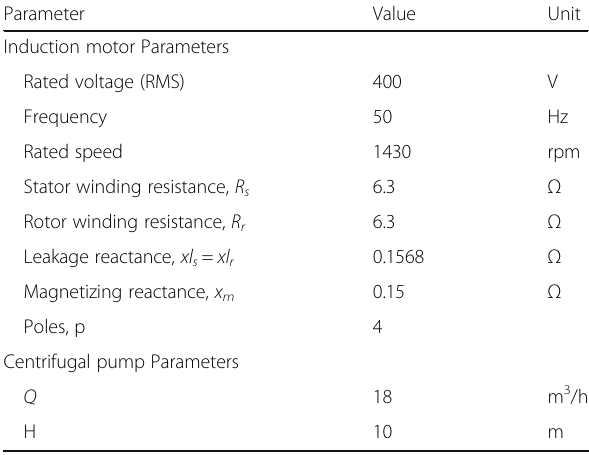
Table 3 Motor pump set